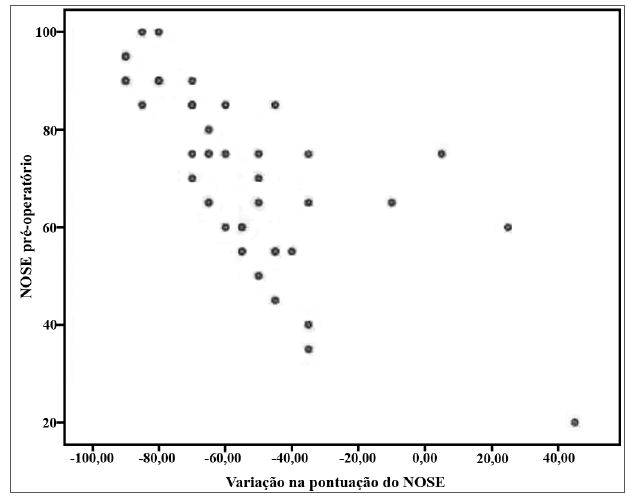
Figura 2. Correlação entre a pontuação pré-operatória no questionário NOSE e a melhora na pontuação após três meses (r = 0,789, p <